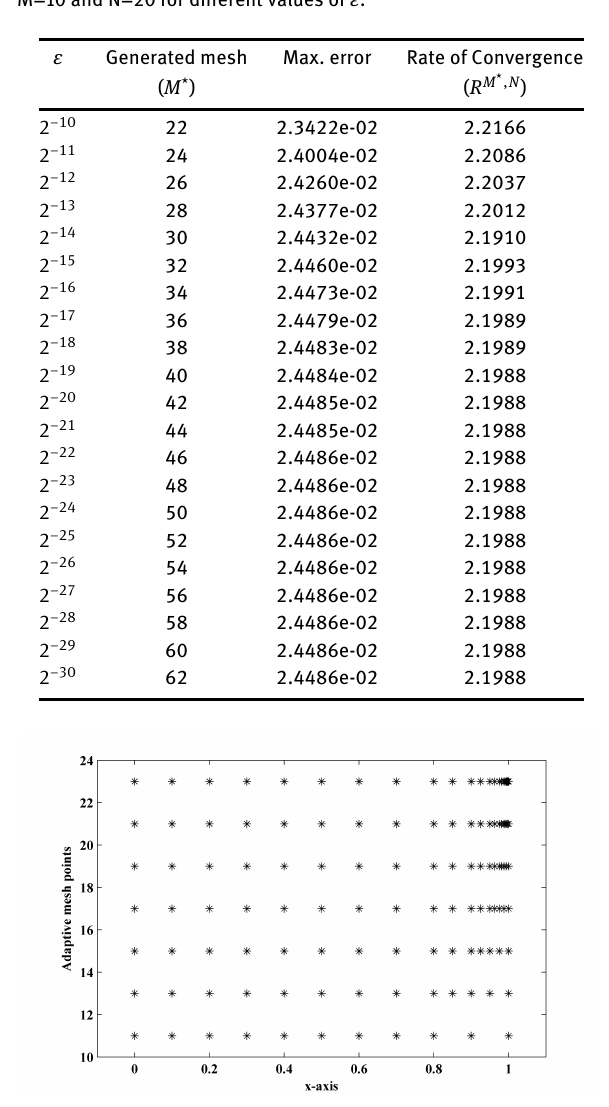
Table 1: Maximum point wise errors of the solution and correspond- ing rate of convergence for Example 5.1 by taking δ = 0.6 , η = 0.7 , M=10 and N=20 for different values of ε .